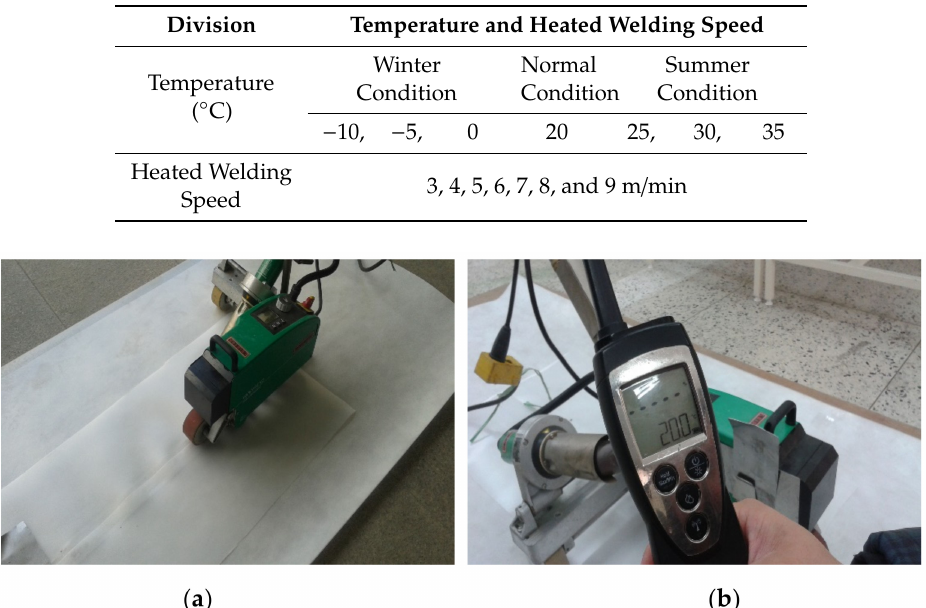
Table 3. Temperature and hot air welding speed conditions.